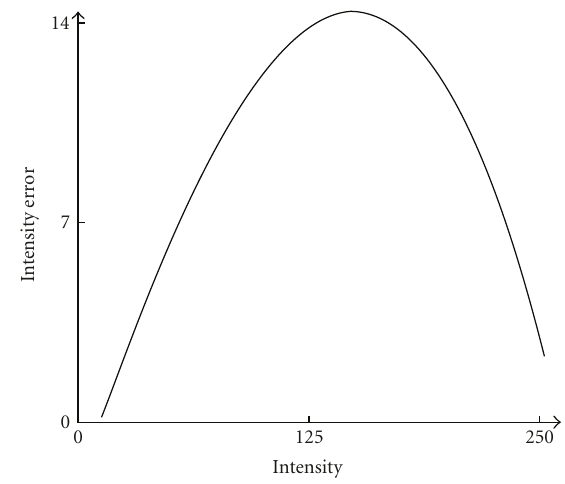
Figure 4: Theoretical intensity error profile as a function of intensity (all units are